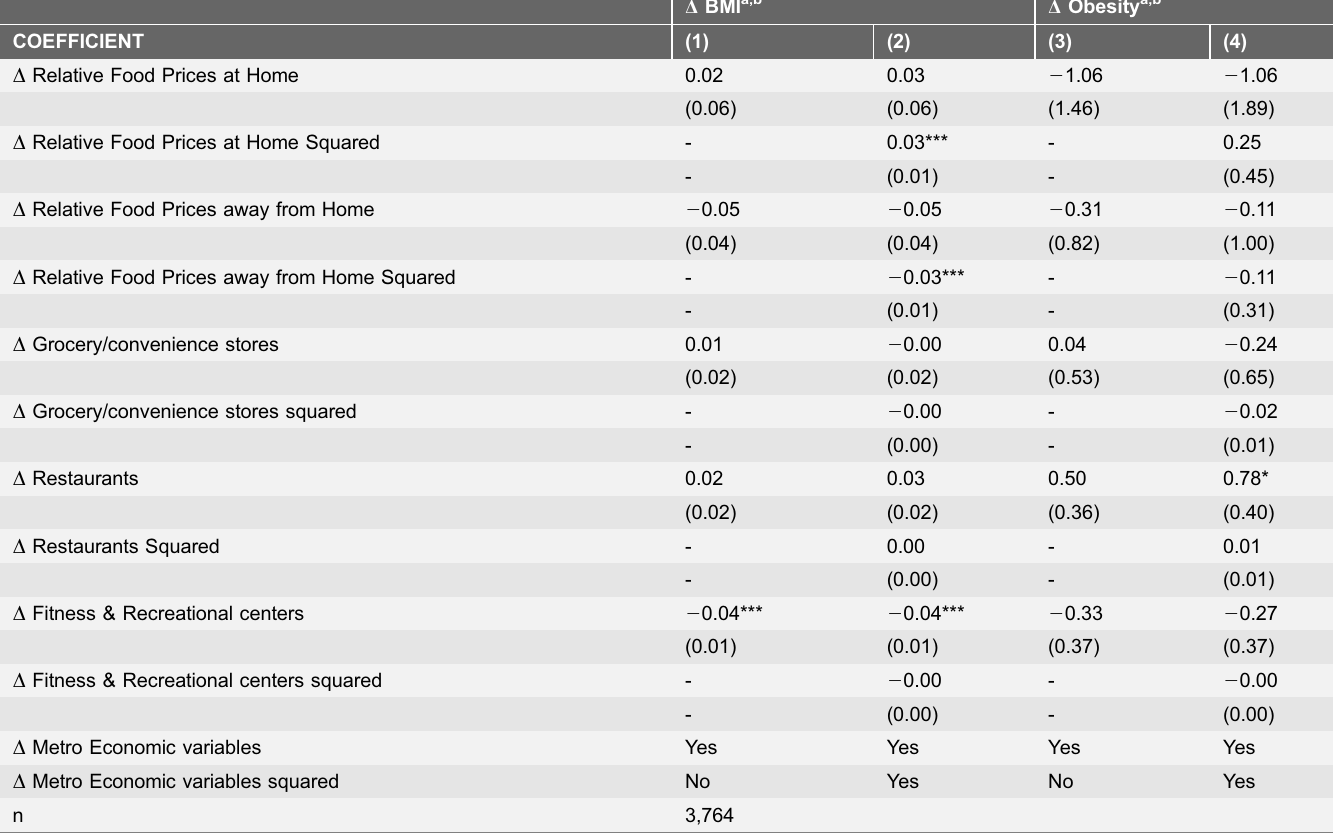
Table 4. The Estimated Effects of Relative Food Price Changes on BMI and Obesity: The